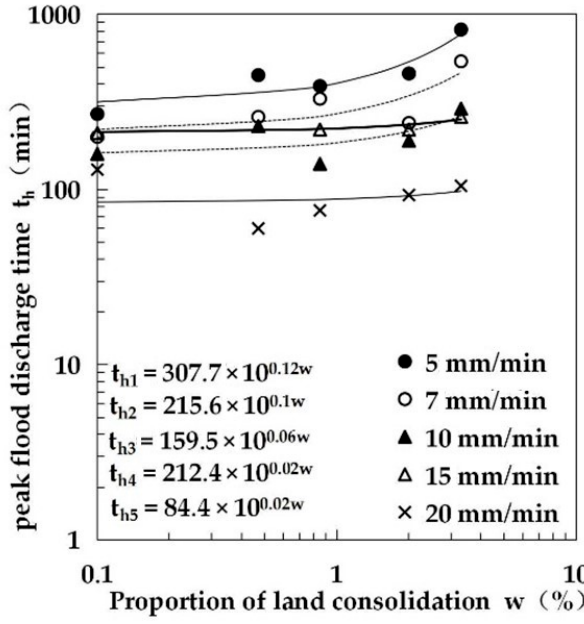
Figure 21. Changes in peak flood discharge time with the proportion of land consolidation under different rainfall intensities.